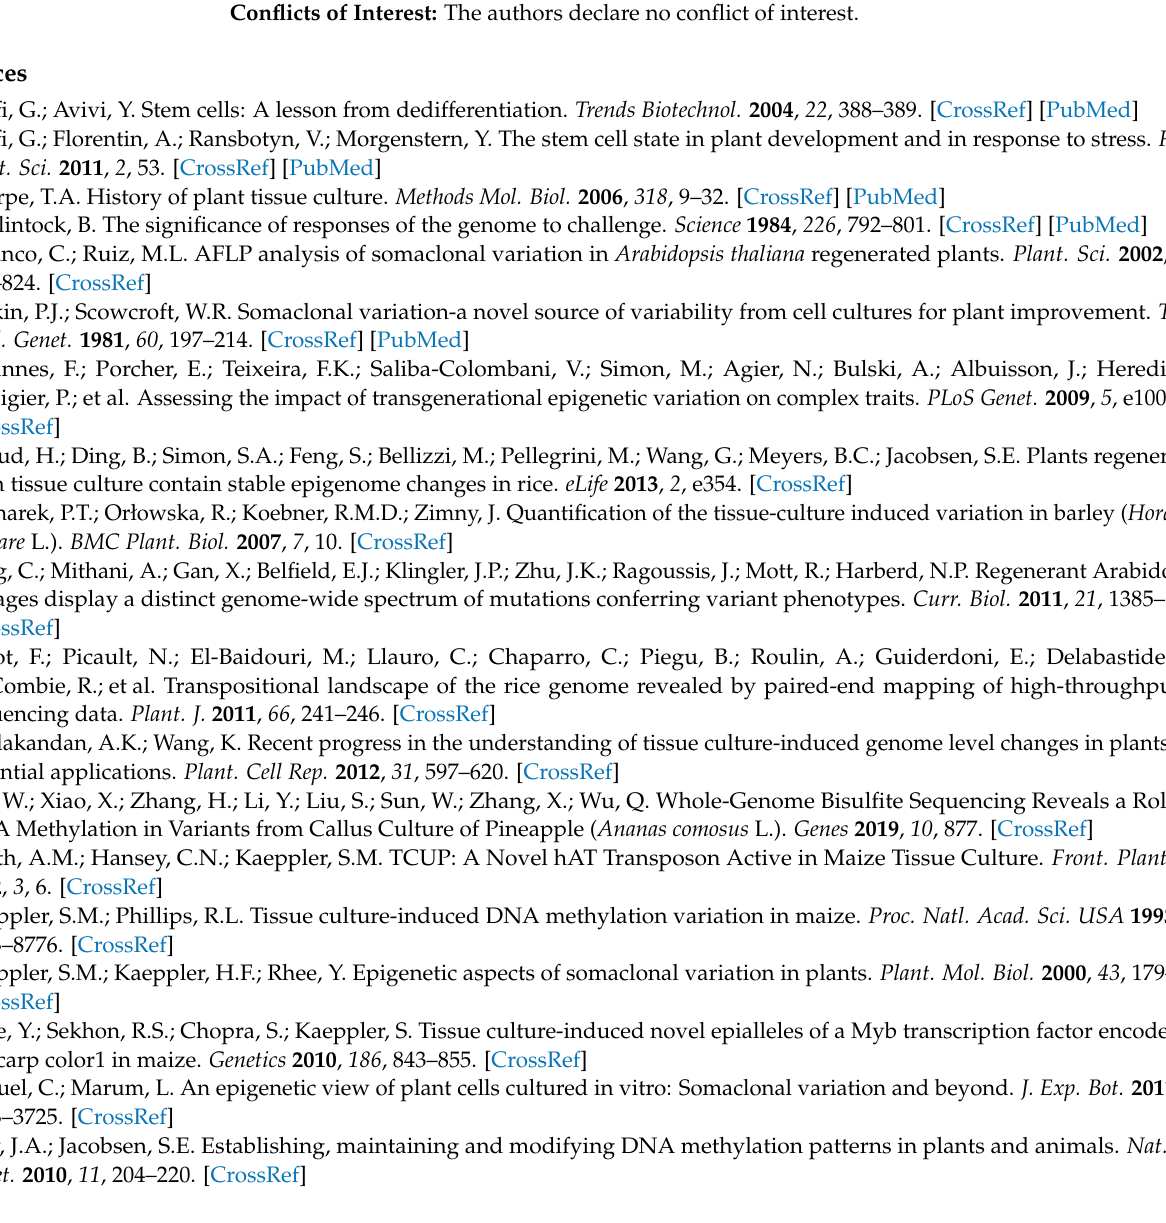
Table S4: The stem-loop structure of precursor RNA of the novel miRNAs in WT and RL; Table S5: Target genes of miRNAs; Table S6: A summary of miRNAs and their target genes